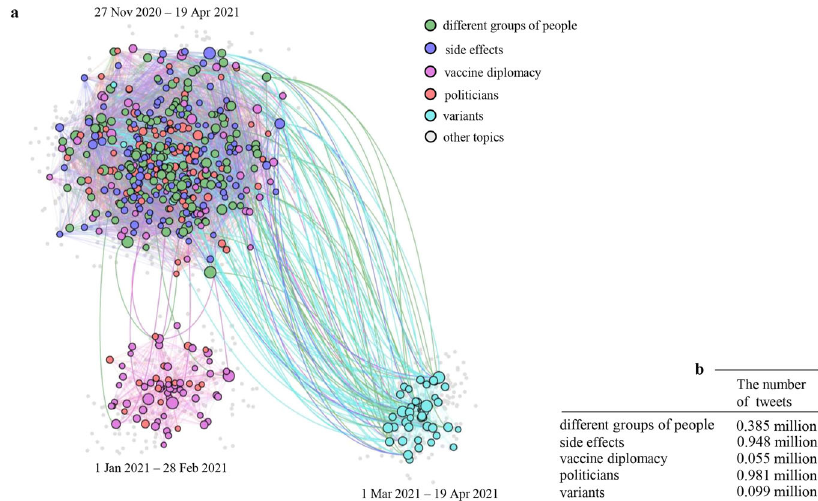
Fig. 1 The landscape of public opinion transmission with regard to vaccine-related topics. a The dynamic landscape of global opinion transmission could be divided into three stages that include the following topics: different groups of people (green), side effects (blue), politicians (red), vaccine diplomacy (magenta), variants (cyan), and other topics (grey). The size of the dots denotes the degree of topic discussion. The lines between the dots represent the mutual in fl uence across different topics. b The number of tweets involved in different topics. Data were retrieved between 27 November 2020 and 19 April 2021. Topics were categorized based on the keywords in tweets (see the